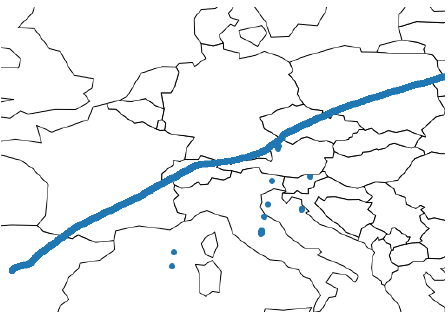
Figure 1. Data discrepancies on a flight between Madrid and